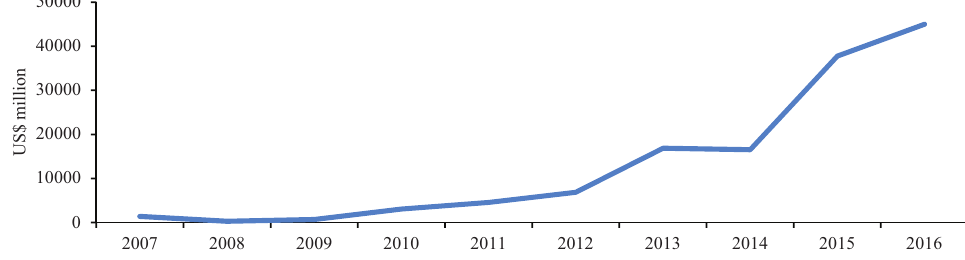
Figure 1. Chinese outward real estate investment (source: Real Capital Analytics [RCA], 2017)